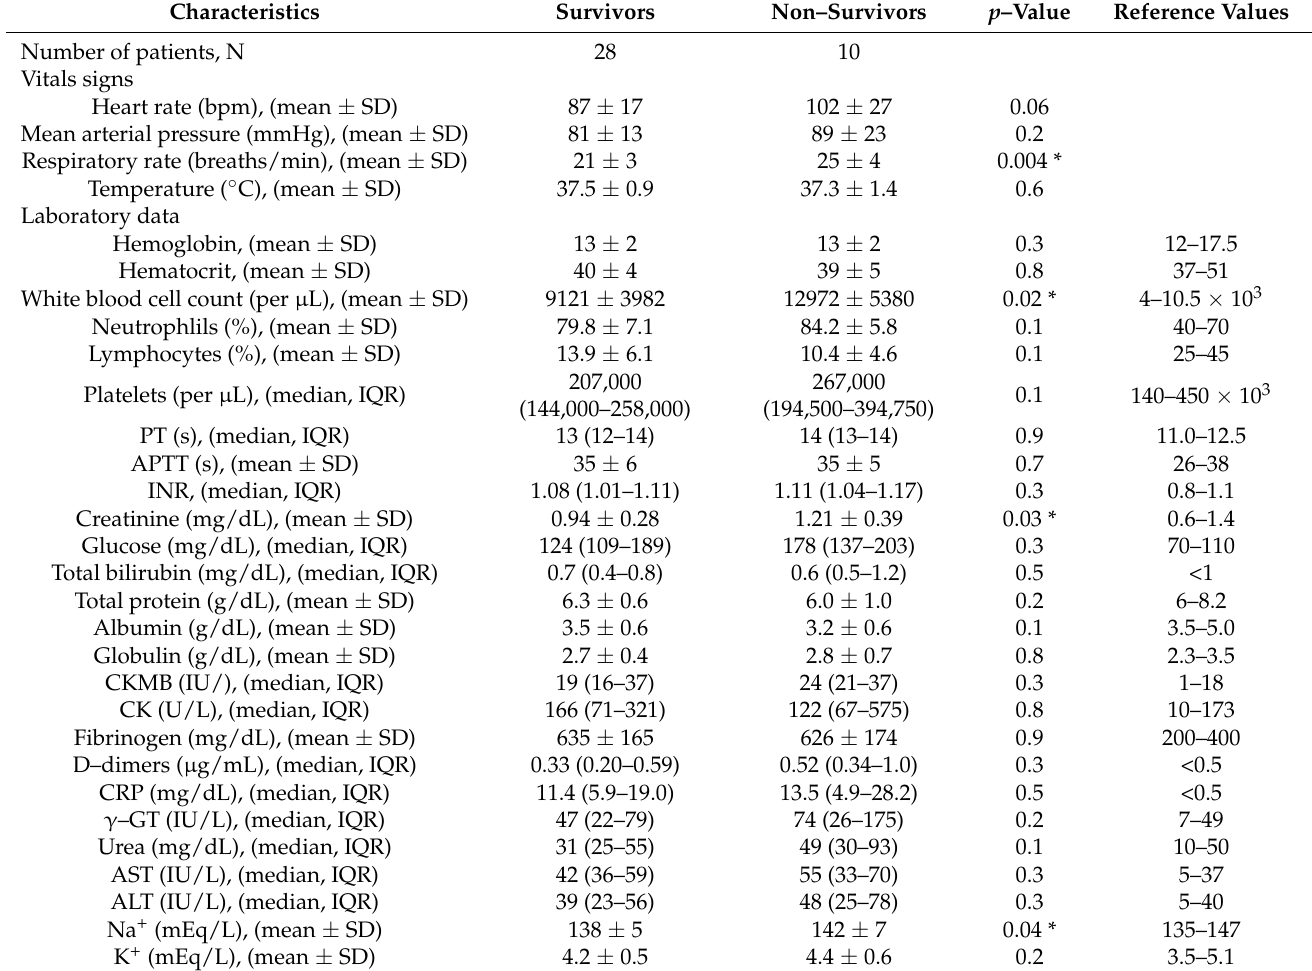
Table 1. Laboratory data of the critically ill patients upon intensive care unit (ICU) admission.